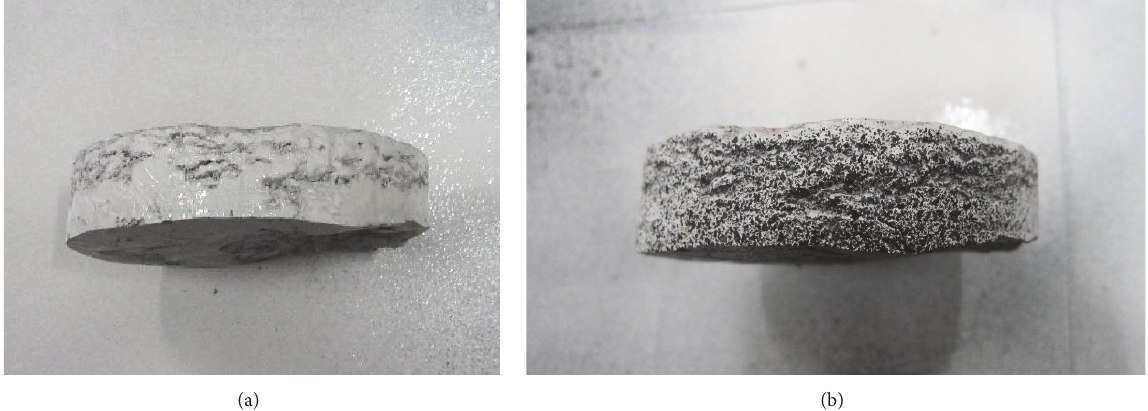
Figure 4: Surface treatment of the specimens sprayed with white paint (a) and with black speckles